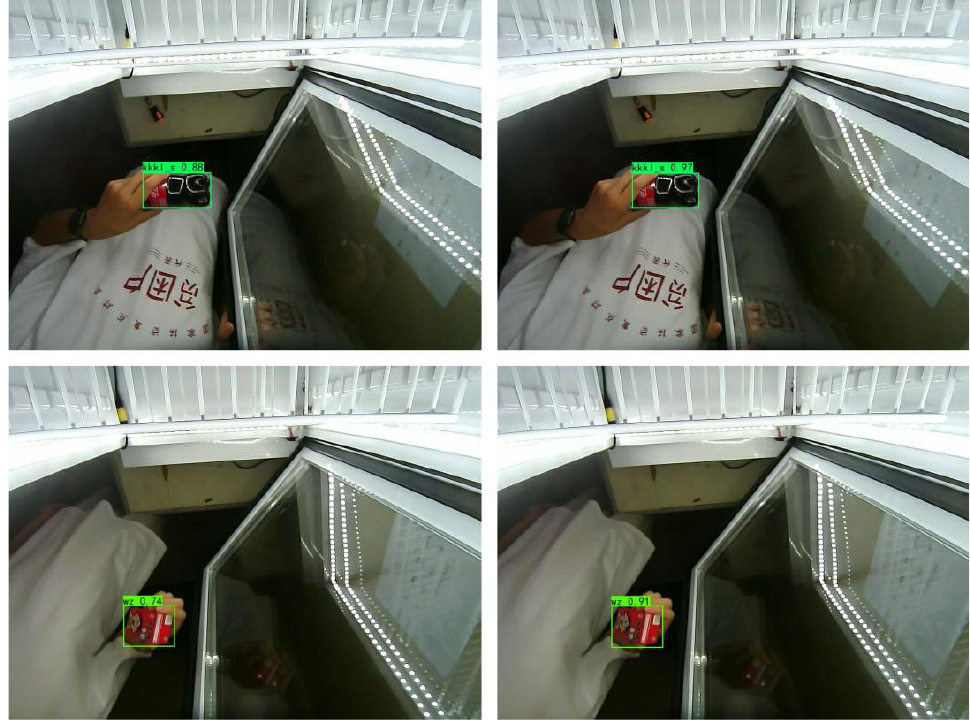
Figure 12. Detection results with and without the attention mechanism.